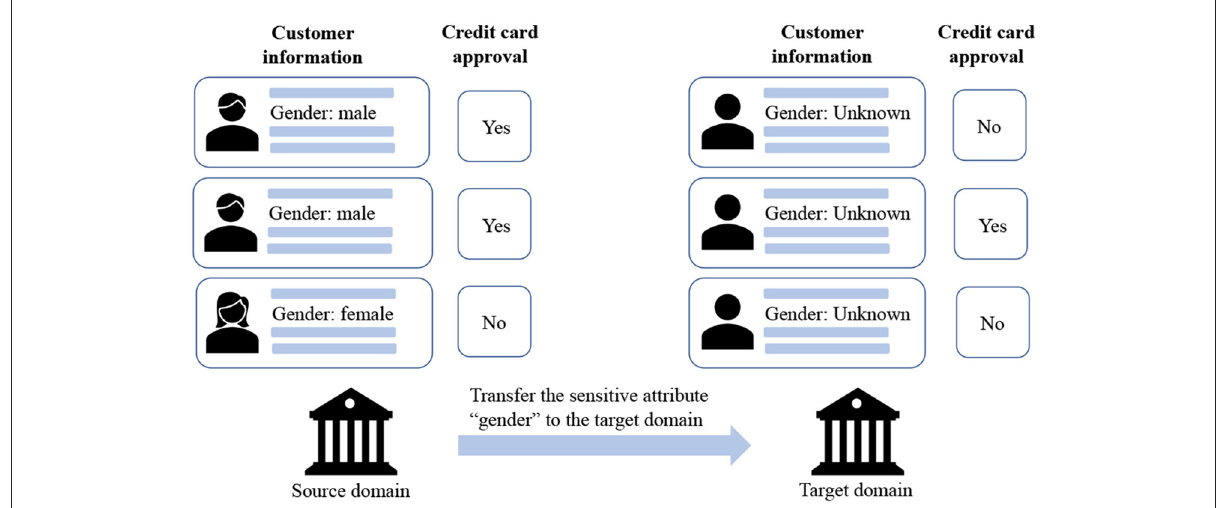
FIGURE1 An illustration of cross-domain fair classification. The information of the sensitive attribute is available in the source domain, while unavailable in the target domain.